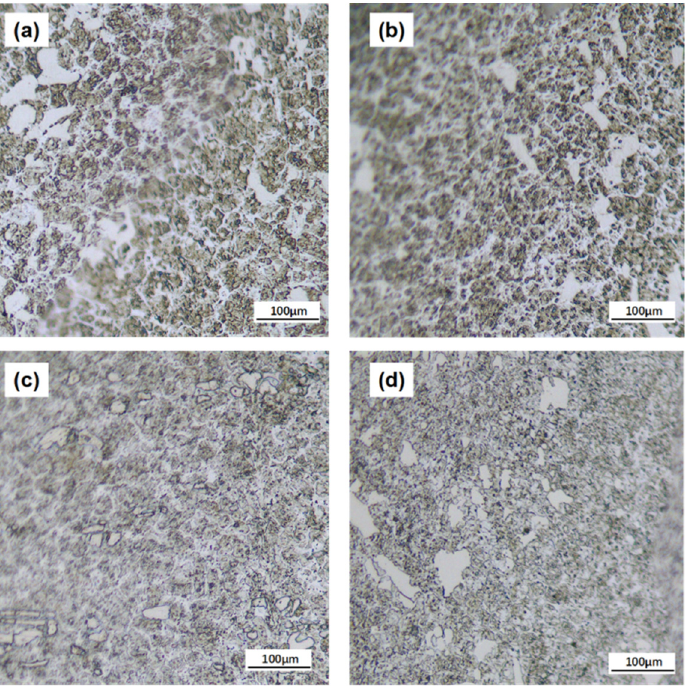
Figure 4. Microstructure of Cr12MoV laser-hardened layer specimens after different numbers of laser shock treatments. ( a ) LQ-LSP1; ( b ) LQ-LSP 2; ( c ) LQ-LSP 3; ( d ) LQ-LSP 4.